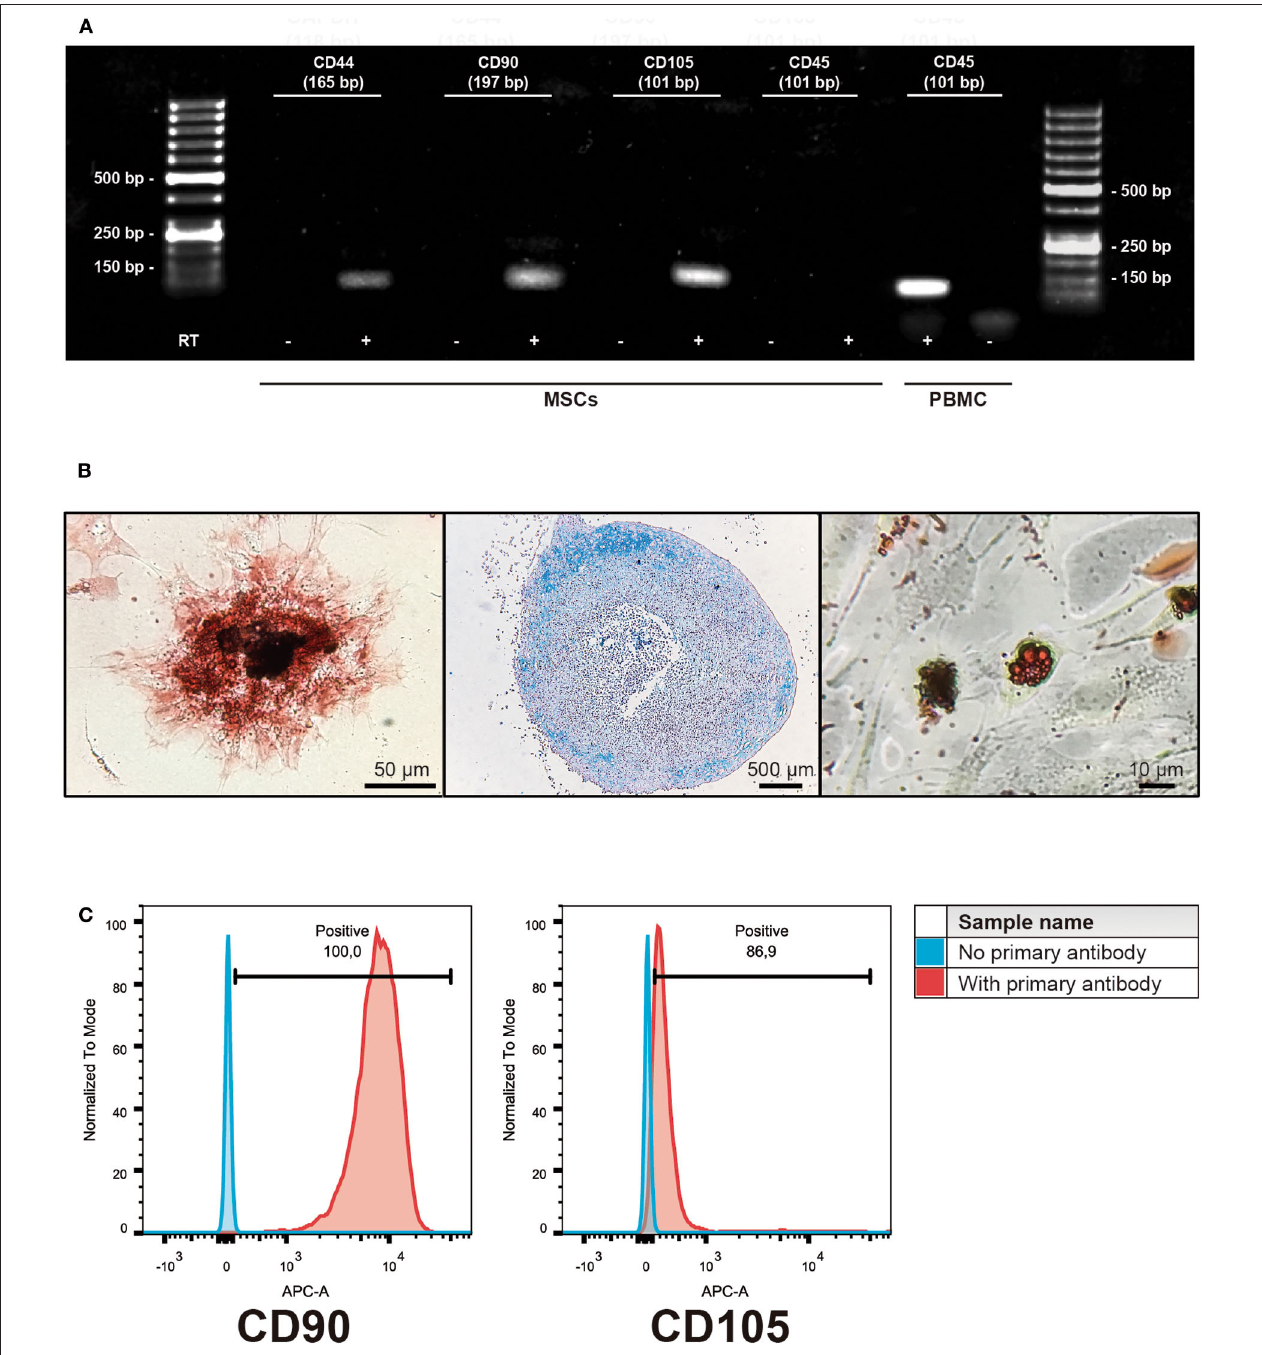
FIGURE 1 | Characterization of isolated bone marrow-derived mesenchymal stromal cells (MSCs). (A) Representative gel of the isolated subpopulations, indicating the expression of MSCs markers CD44, CD90, and CD105; hematopoietic marker CD45 expression was absent in MSCs. PBMC cDNA was used as a control of CD45 expression. ( + ) indicates cDNA synthesis including reverse transcriptase (RT) while (-) indicates controls without the enzyme in order to identify amplification of non-specific products. (B) Representative example of trilinear differentiation of isolated bone marrow-derived MSCs, showing the osteogenic lineage stained with Alizarin red 2% (left panel), chondrogenic stained with Alcian blue 1% (middle panel) and adipogenic stained with Oil red (right panel) lineages. (C) Representative histograms of flow cytometry determinations for CD90 and CD105 of the isolated cell populations.